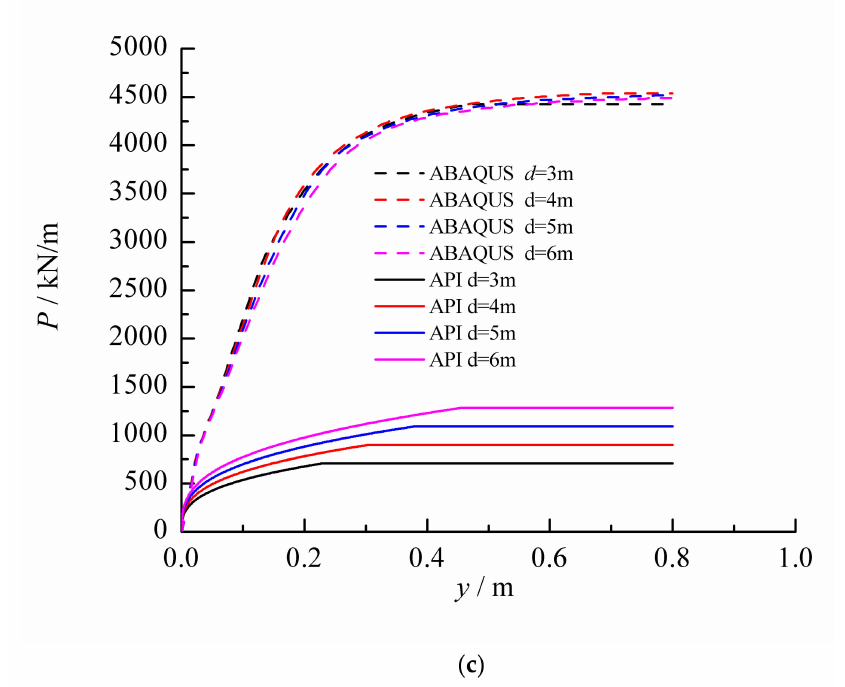
Figure 15. p - y curve at different depths. ( a ) Depth of 2.25 m. ( b ) Depth of 3.75 m. ( c ) Depth of 5.25